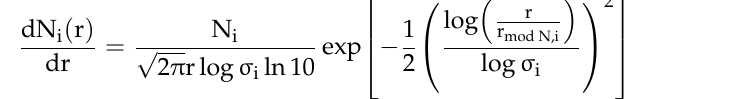
Table 1. Aerosol microphysical properties and height information for the mixture aerosol types from OPAC database.